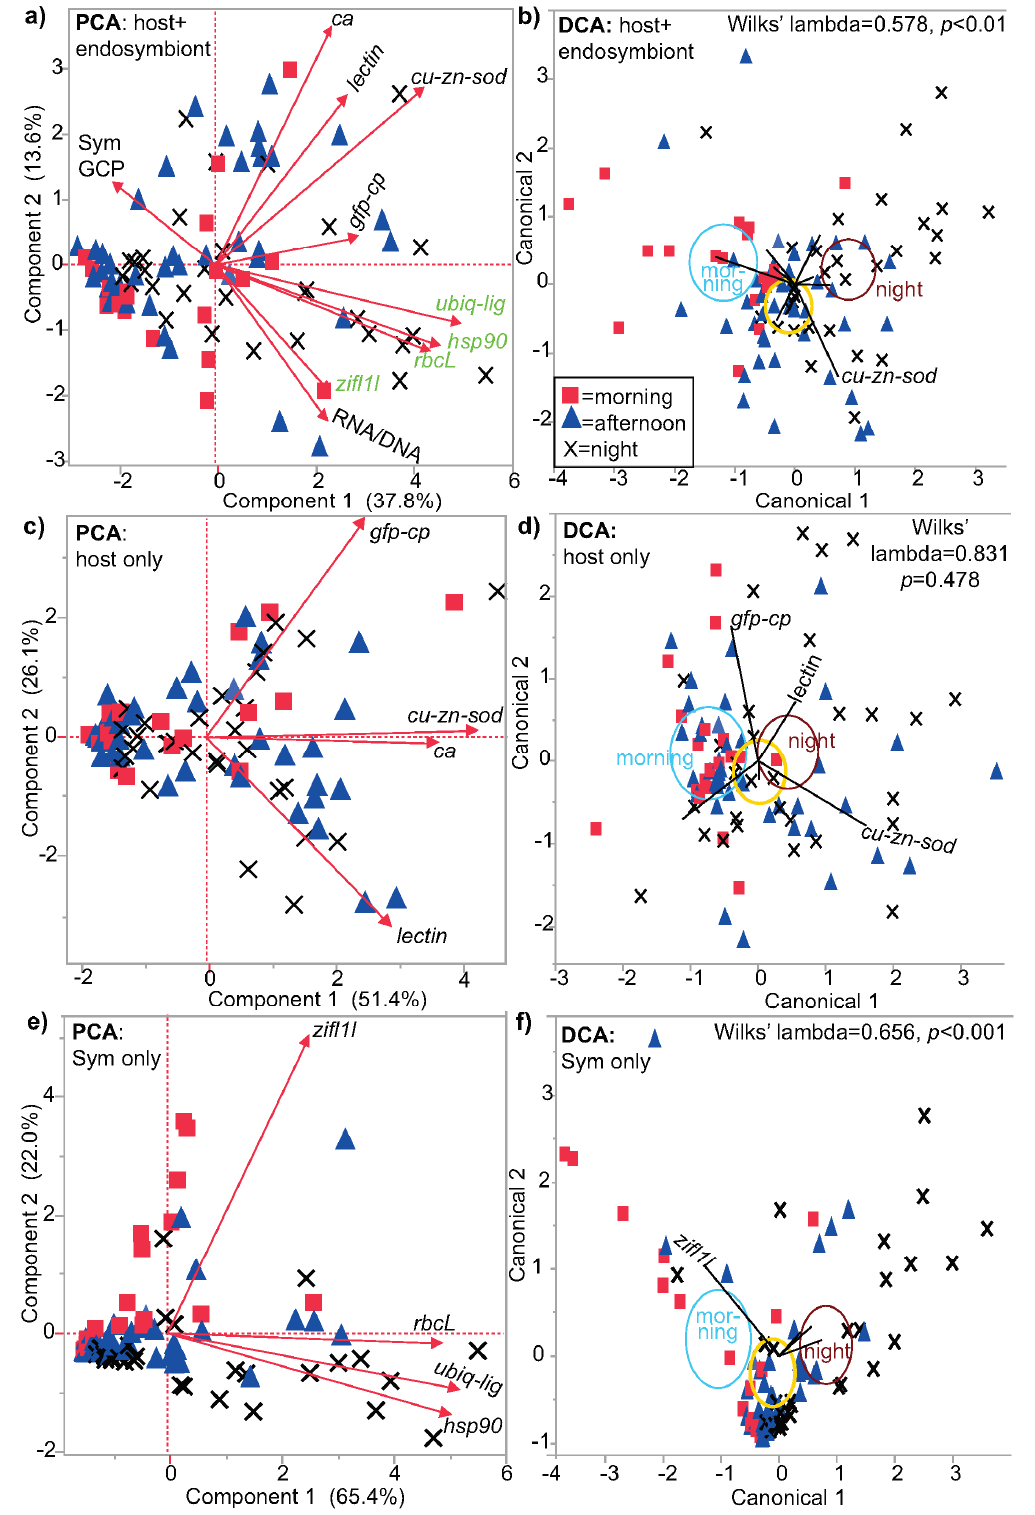
Figure 1. Multivariate effects of sampling time on coral physiology. Both PCA (on correlations; ( a , c , e )) and DCA (on standardized data; ( b , d , f )) were used to depict molecular-physiological data in two dimensions such that relationships among corals sampled at different times—morning (<10:00; red squares), afternoon (10:00–14:00; blue triangles), and night (18:00–20:00; black exes)—could be explored. All 10 response variables (both compartments; ( a , b )), as well as the four host coral ( c , d )